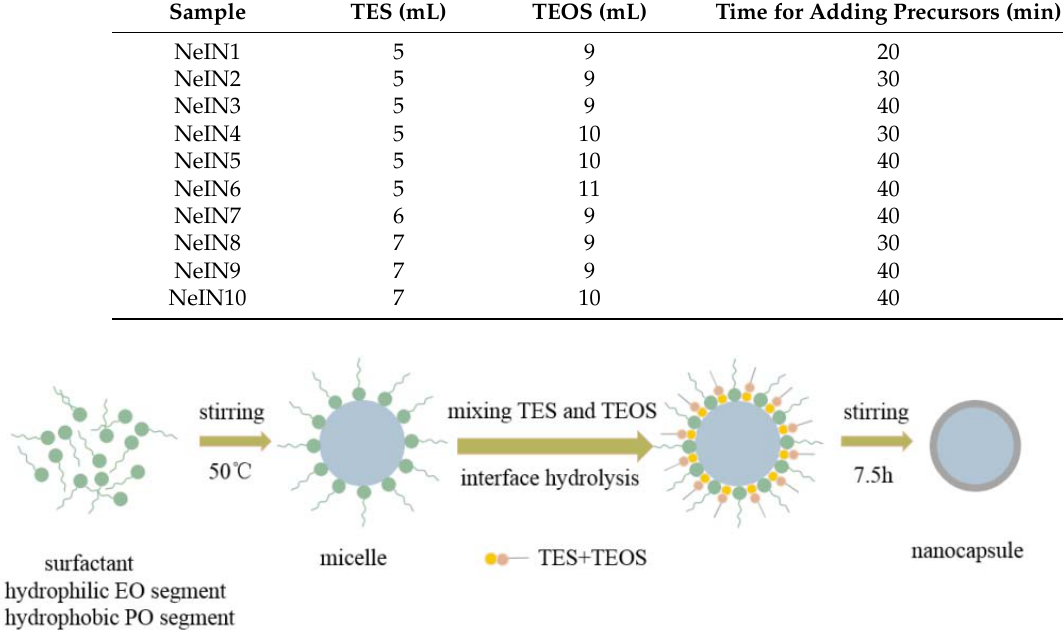
Figure 1. Schematic formation of the inositol@SiO 2 nanocapsules via the sol − gel process. Table 1. Synthesis parameters for the preparation of the nanocapsules. Sample